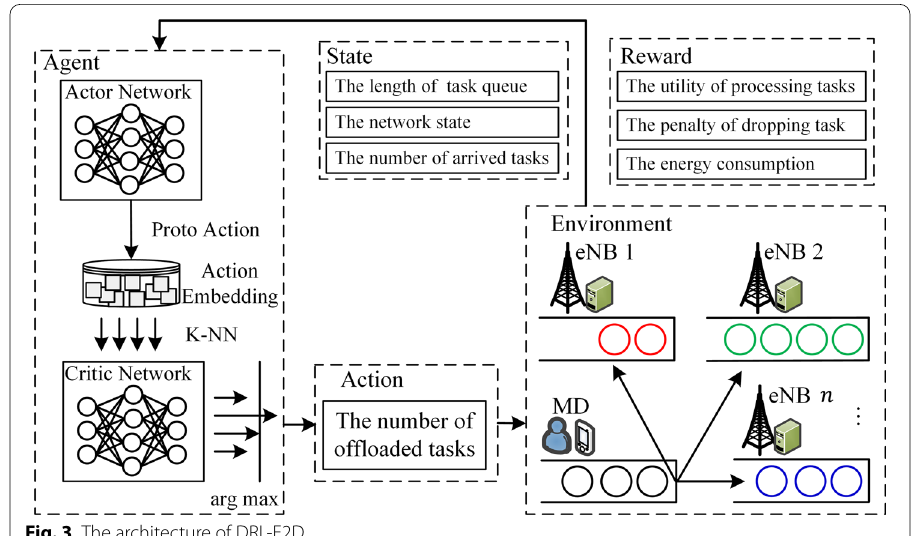
Fig. 3 The architecture of